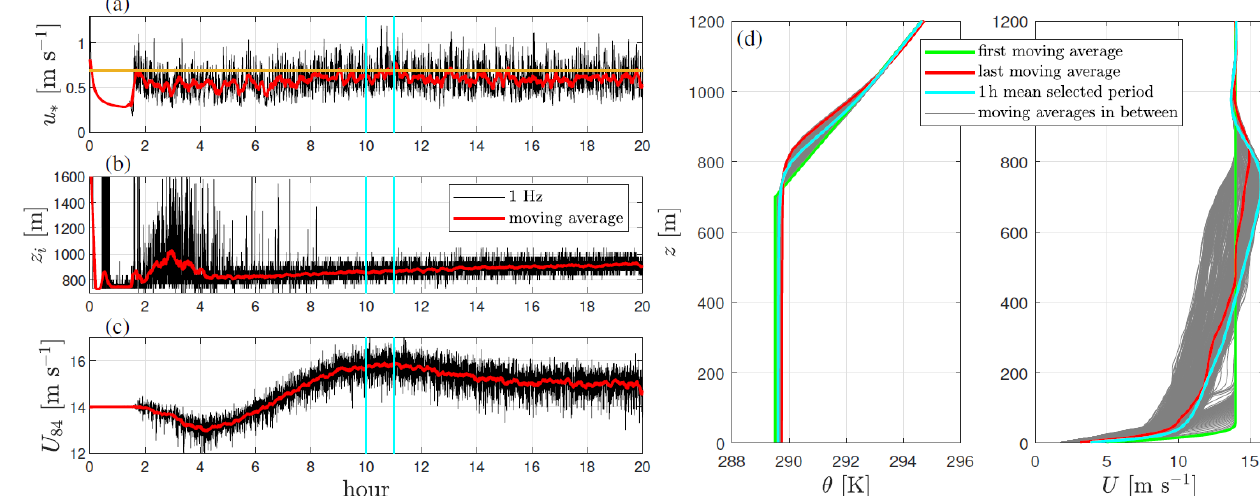
Figure 3. (a–c) Time series of selected WRF-LES outputs and estimated variables for the neutral ABL simulation. The solid line in ochre shows the observed friction velocity and the cyan vertical lines the selected 1h period. (d) A number of moving averages of vertical profiles of potential temperature and horizontal wind speed magnitude during the simulation. The mean vertical profiles for the selected 1h period are also highlighted.